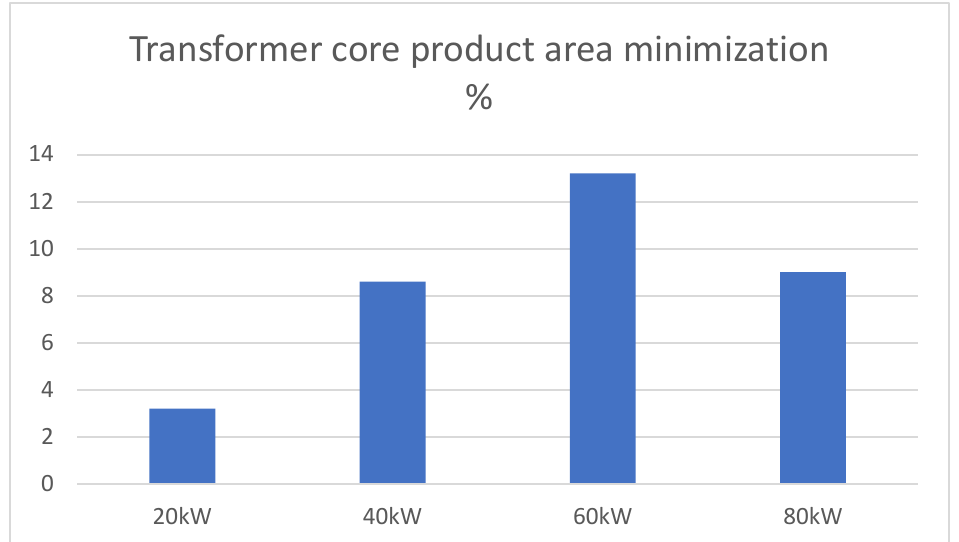
respect to optimal EPS operation for different values of nominal power.